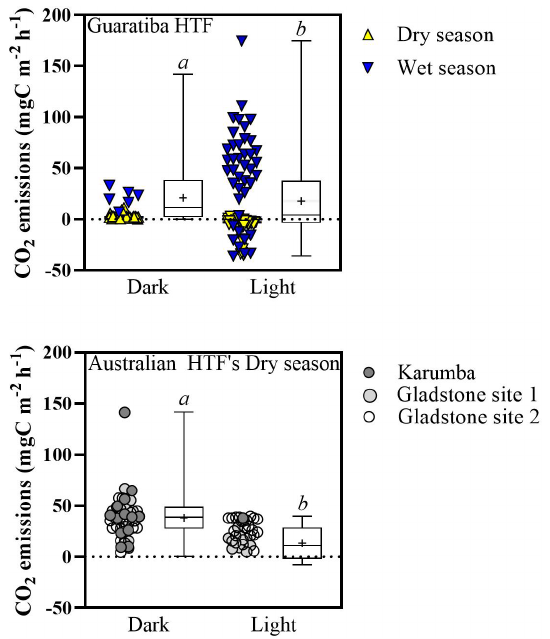
Figure 5. Median air–sediment CO 2 fluxes (mgCm − 2 h − 1 ) from hypersaline tidal flat sediments of Guaritiba, Brazil (dry season rep- resented by yellow triangles – n = 44 for dark chambers and n = 53 for light chambers; wet season represented by blue triangles – n = 6 for dark chambers and n = 41 for light chambers), and Australia (Gladstone sites represented by light grey and white circles – n = 33 for dark chambers and n = 31 for light chambers; Karumba site rep- resented by dark grey circles – n = 13 for dark chambers and n = 1 for light chambers). Negative values represent net CO 2 influx to sediments, while positive values represent net CO 2 emission to the atmosphere. Average values are represented by crosses, and error bars denote minimum to maximum. Different letters indicate sig- nificant differences (Mann–Whitney; p < 0 .